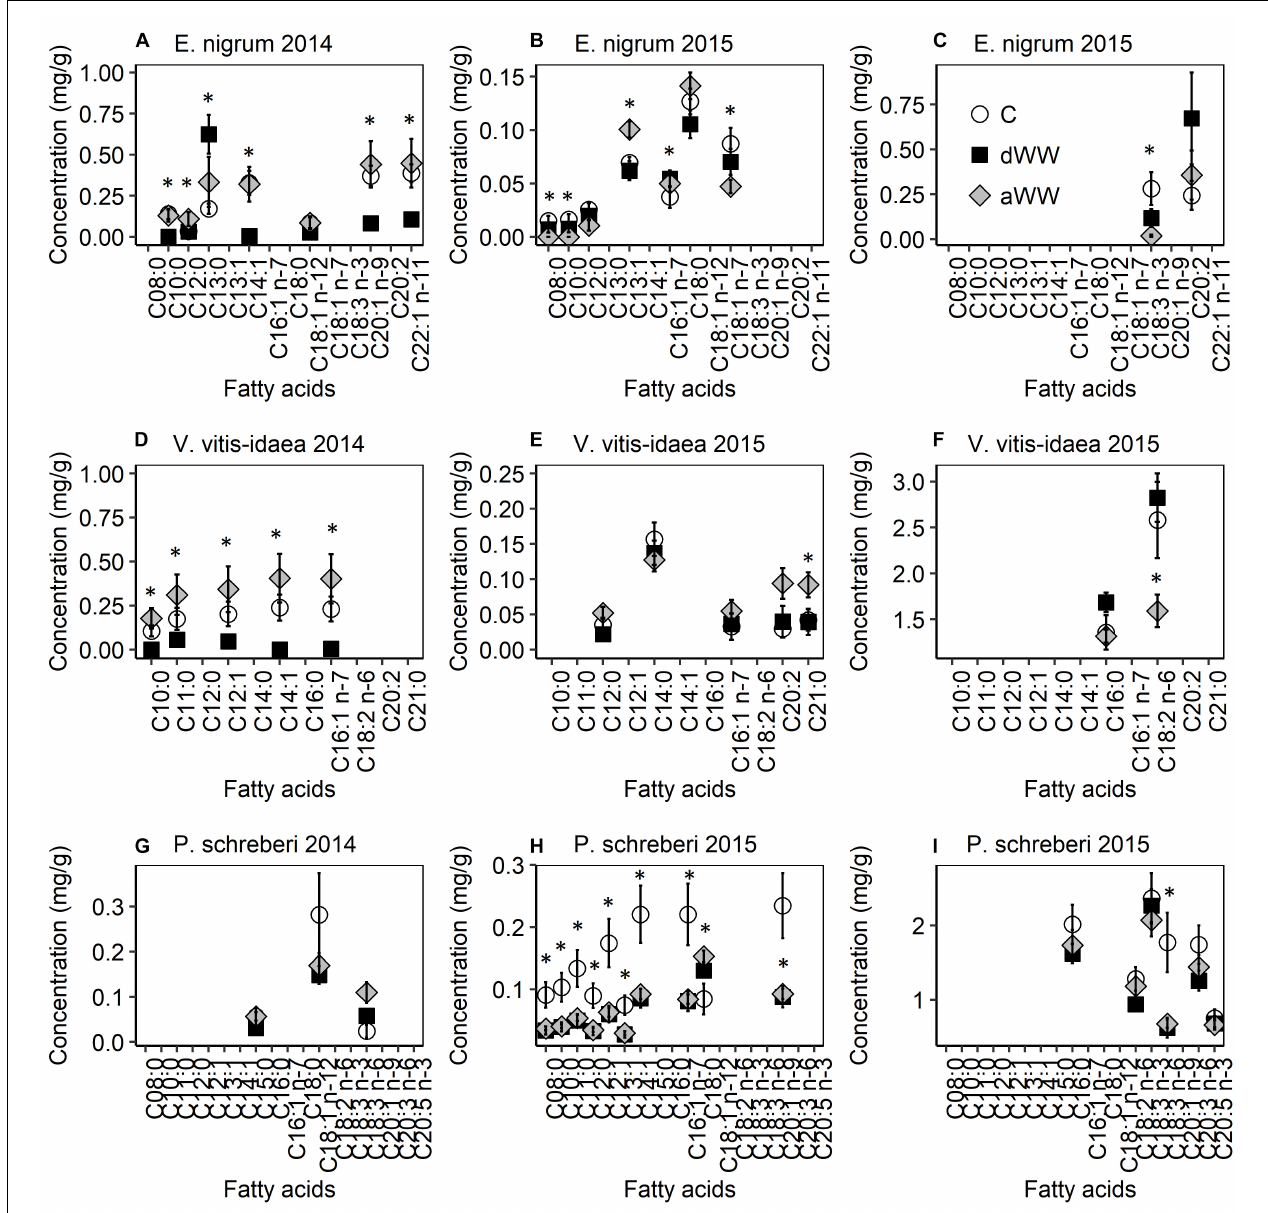
FIGURE 2 | Composition of cell membrane fatty acids of Empetrum nigrum (A–C) , Vaccinium vitis-idaea (D–F) , and Pleurozium schreberi (G–I) measured during (dWW) and after (aWW) extreme winter warming events in 2014 and 2015. Note that for clarity the 2015 fatty acids are separated by concentration. Data points are means of five replicate samples with SE as error bars. Asterix indicate significant ( P < 0.05) difference in fatty acid concentrations between extreme winter warming and control